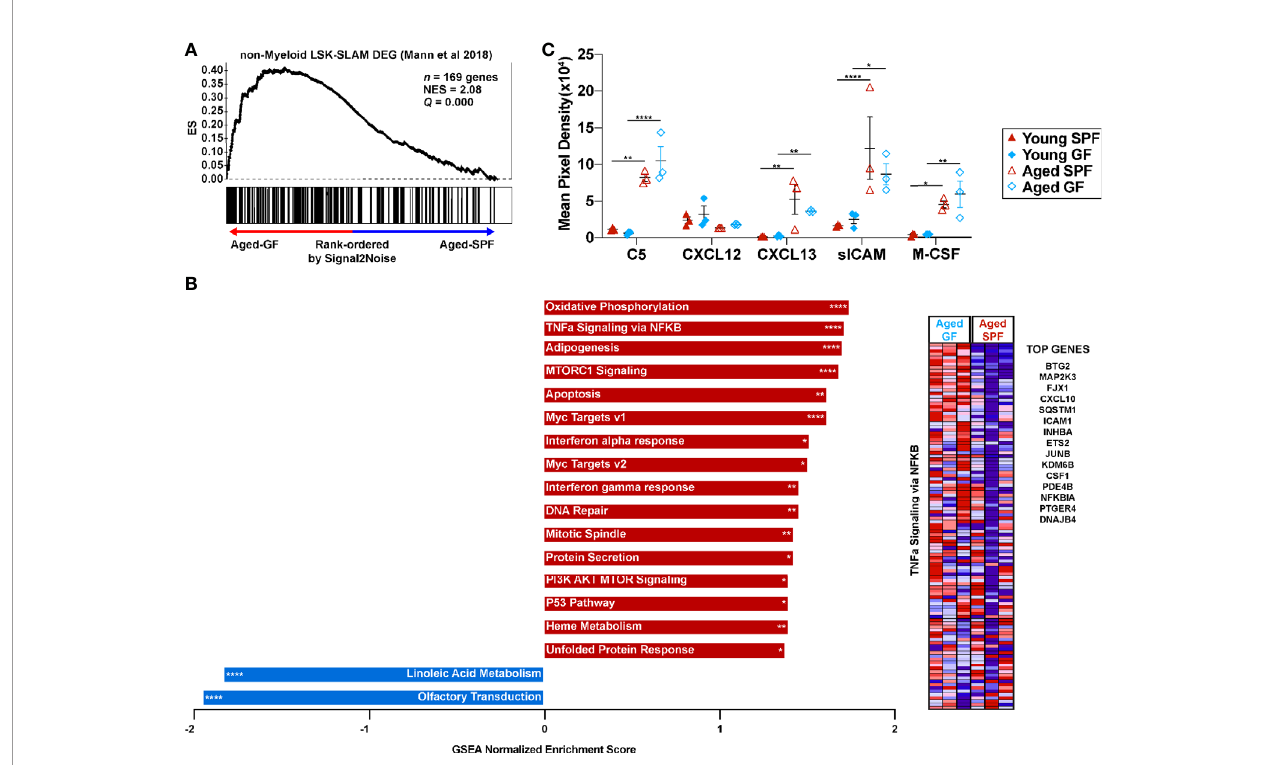
FIGURE 6 | Microbiota signals enhance the myeloid gene signature of HSCs with age but are not required for expression of in fl ammatory mediators in the blood. (A) Gene set enrichment analysis for genes consistent with non-myeloid biased LSK-SLAM cells. (B) Signi fi cantly enriched gene sets from the Hallmark, KEGG, and Reactome gene sets (adjusted FDR< 0.1, nominal p-value<0.05). Red bars represent gene sets upregulated in aged GF HSCs and blue bars gene sets upregulated in aged SPF HSCs. *P < 0.05, **P < 0.01, ***P < 0.001, and ****P < 0.0001 by GSEA. Heatmap of the TNFa signaling via NFKB gene set with a list of the top 15 differentially expressed genes between aged GF and aged SPF. (C) Quanti fi cation of arrays that interrogate in fl ammatory cytokines/chemokines hybridized with serum. Data represent the mean ± SEM. *P < 0.05, **P < 0.01, and ****P < 0.0001 by two-way ANOVA with alpha = 0.05 and Sidak ’ s multiple comparisons